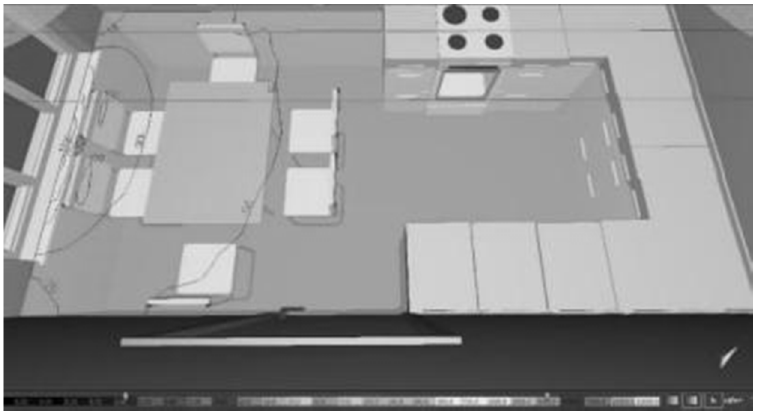
Figure 6. The uneven pattern of the daylight simulation at sub-scenario A, 6:00 a.m., 1 May 2019, in DIALuxEvo 8.1.